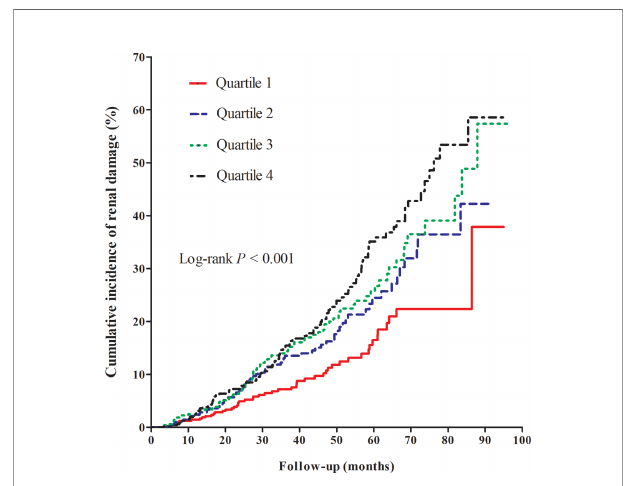
FIGURE 1 | Kaplan – Meier curve of cumulative incidence of renal damage across quartiles of Chinese visceral adiposity index.